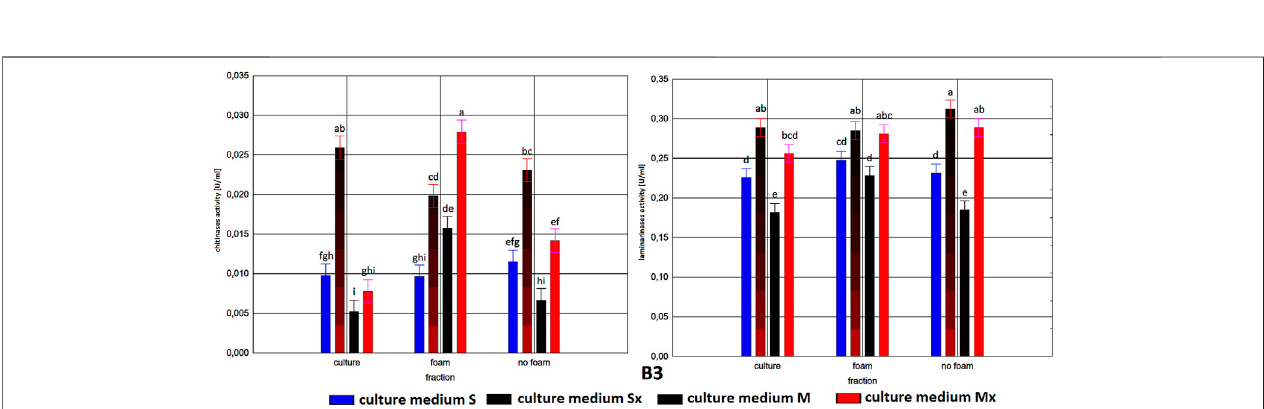
FIGURE2| Enzymaticactivitiesin threefractions:raw (R),foam (F), foaming residue (FR), of Trichodermacitrinoviride C1straincultivatedindifferentculture media, after separation with foaming technique (M) MGP medium, (S) Saunders medium, (Mx) MGP medium with inductors, (Sx) Saunders medium with inductors. One-way analysis of variance (ANOVA) was applied; a ... i — homogeneous groups according to Duncan ’ s test.